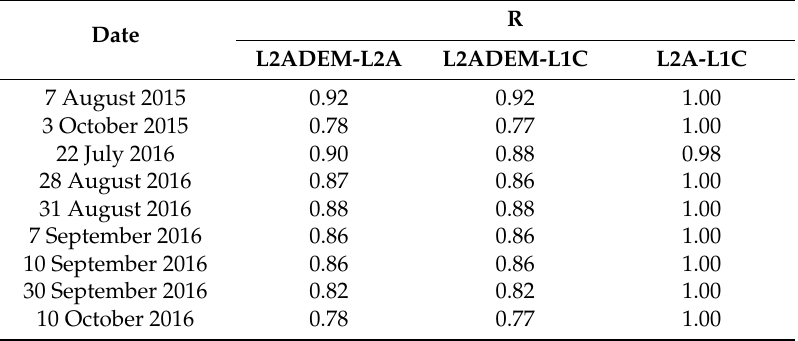
Table 8. Correlation between the treefall gap abundance rasters on different data types on different dates on OS2.